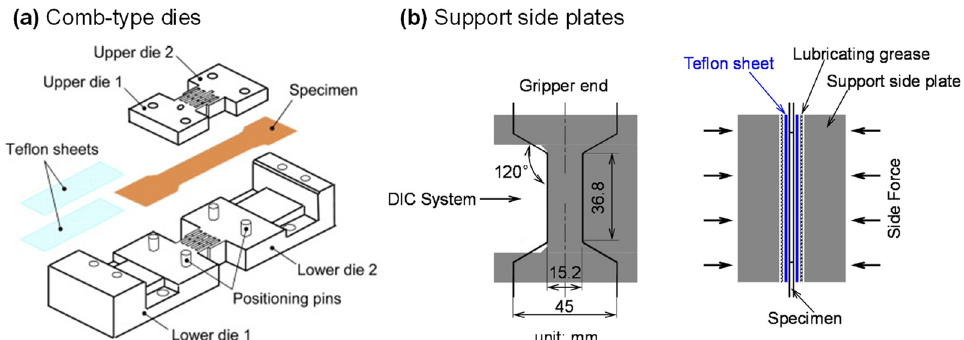
Figure 17. Experimental apparatus for UC tests of sheet metals: ( a ) configuration of the dies. Reprinted from Ref. [246] with permission. Copyright 2009, Elsevier; ( b ) the support side plates. Reprinted from Ref. [248] with permission. Copyright 2021, Elsevier.